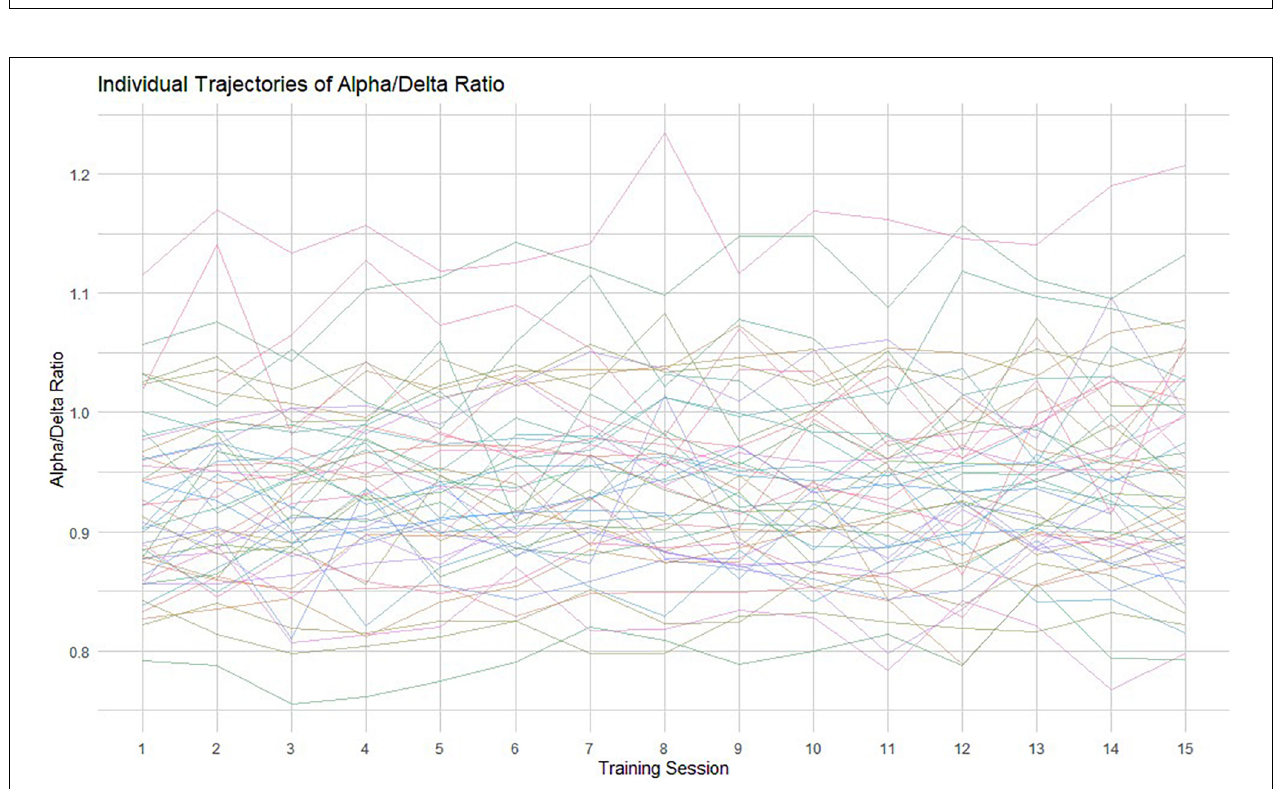
FIGURE 2 | Individual raw data trajectories of the ADR across the 15 measurement occasions. Each thin line represents an individual oscillatory ADR trajectory.